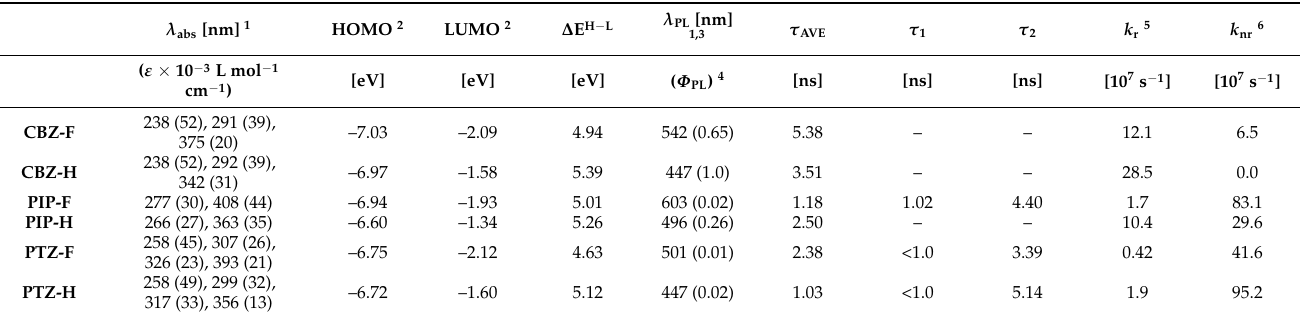
Table 1. Photophysical data of the D- π -A-type tolanes obtained in CH 2 Cl 2 solution and their calcu- lated data.